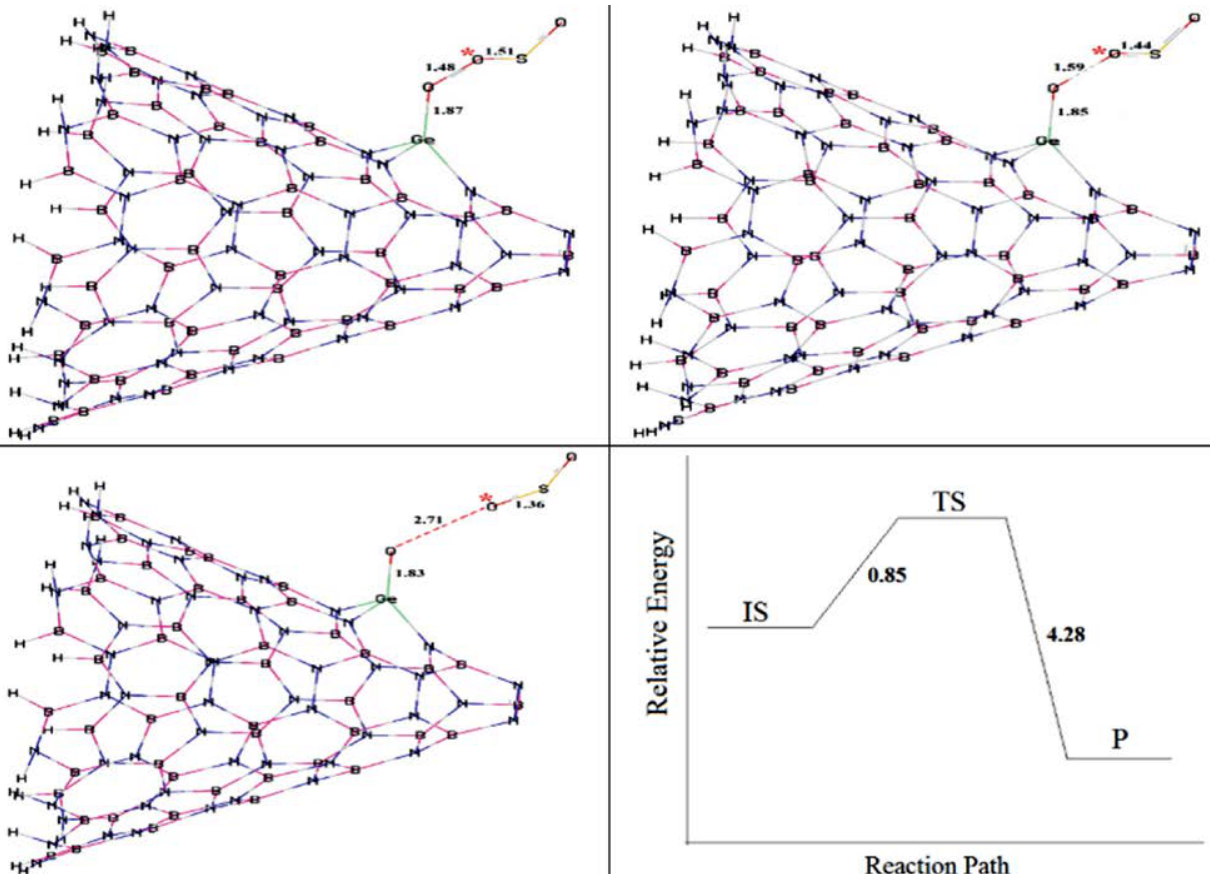
Figure 2. Plan of Ge-BNNC-O-O * + SO → Ge-BNNC-O + SO 2 reaction (Bond distances (Å) and relative energies